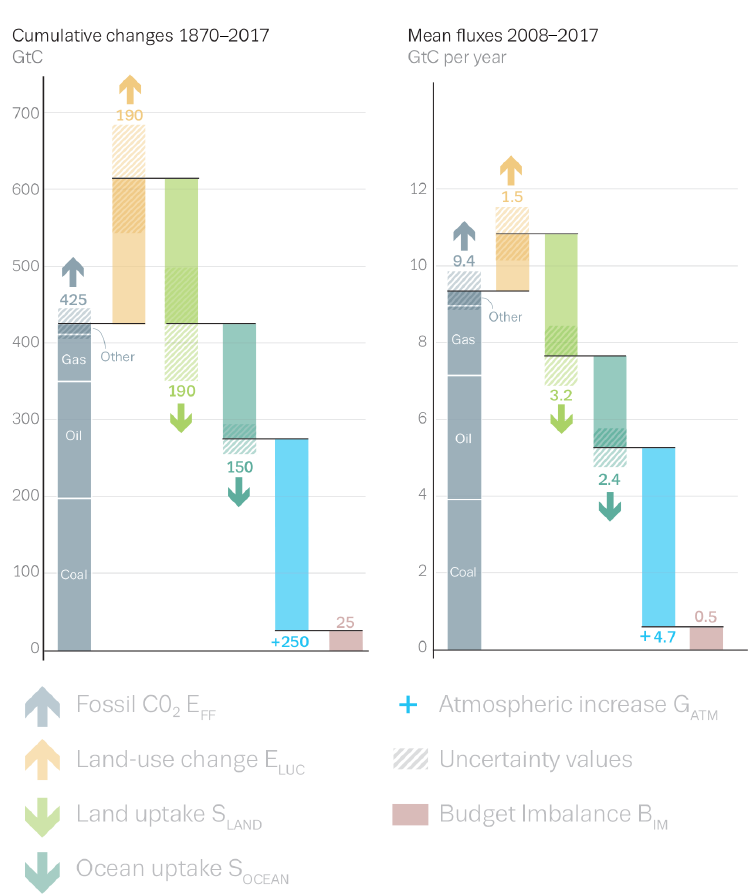
Figure 9. Cumulative changes during 1870–2017 and mean fluxes during 2008–2017 for the anthropogenic perturbation as defined in the